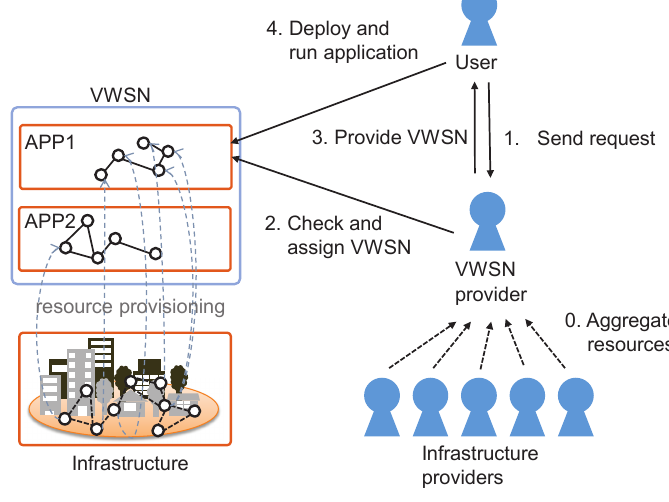
Figure 1. Providing a virtual wireless sensor network (VWSN) to a